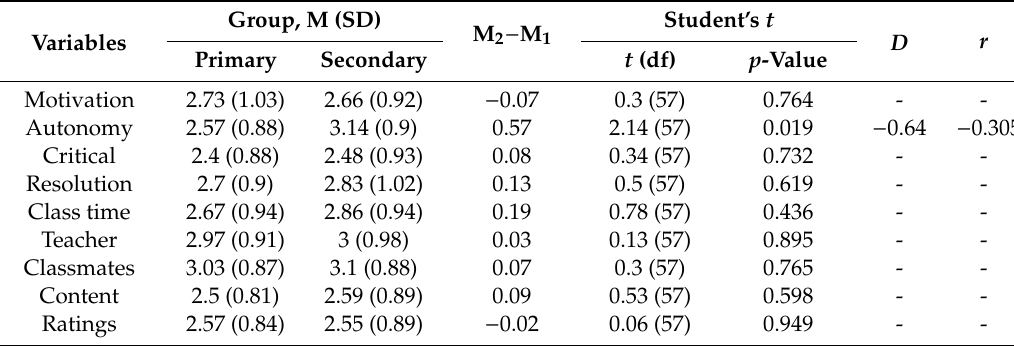
Table 7. Study of the value of independence between experimental